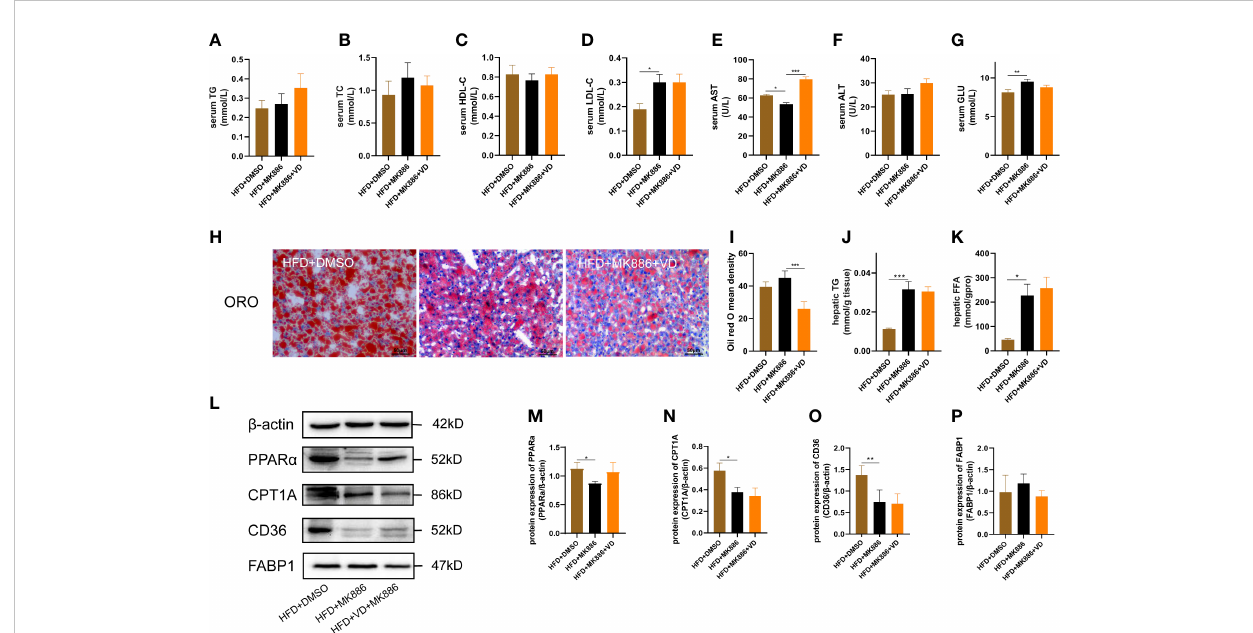
FIGURE 4 MK886 inhibited the effect of Vitamin D3. (A) serum TG, (B) TC, (C) HDL-C, (D) LDL-C, (E) AST, (F) ALT, (G) GLU, (H) Oil red O staining of liver tissue (400 × magni fi cation), (I) Oil red O mean density, (J) hepatic TG, and (K) FFA, (M – P) the fold change in expression of the proteins in (L) relative to the expression of b-actin. *P < 0.05, **P < 0.01, ***P < 0.001.